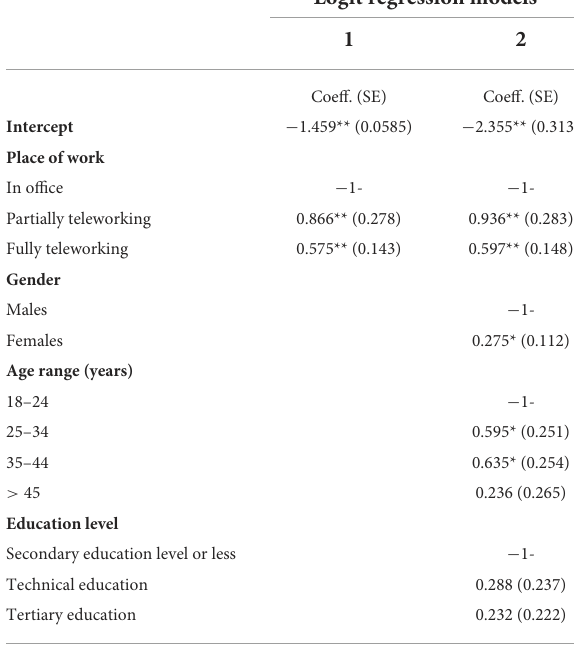
TABLE 4 Regression analysis of experiencing overweight by considering 2 sub-sets of variables: place of work (Logit model 1); place of work, age, and education level (Logit model